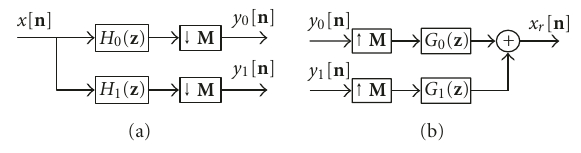
Figure 1: The canonical form of a quincunx filter bank: (a) analysis side, and (b) synthesis